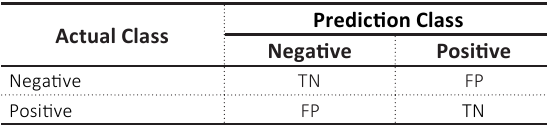
Table 2. Confusion